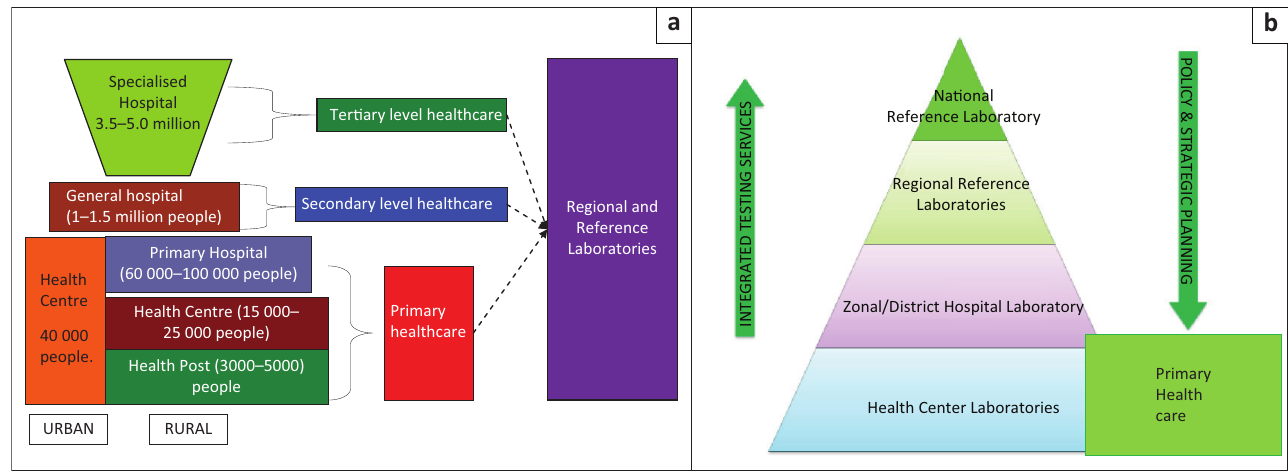
FIGURE 1: Health system and laboratory network: Ethiopia’s referral linkage